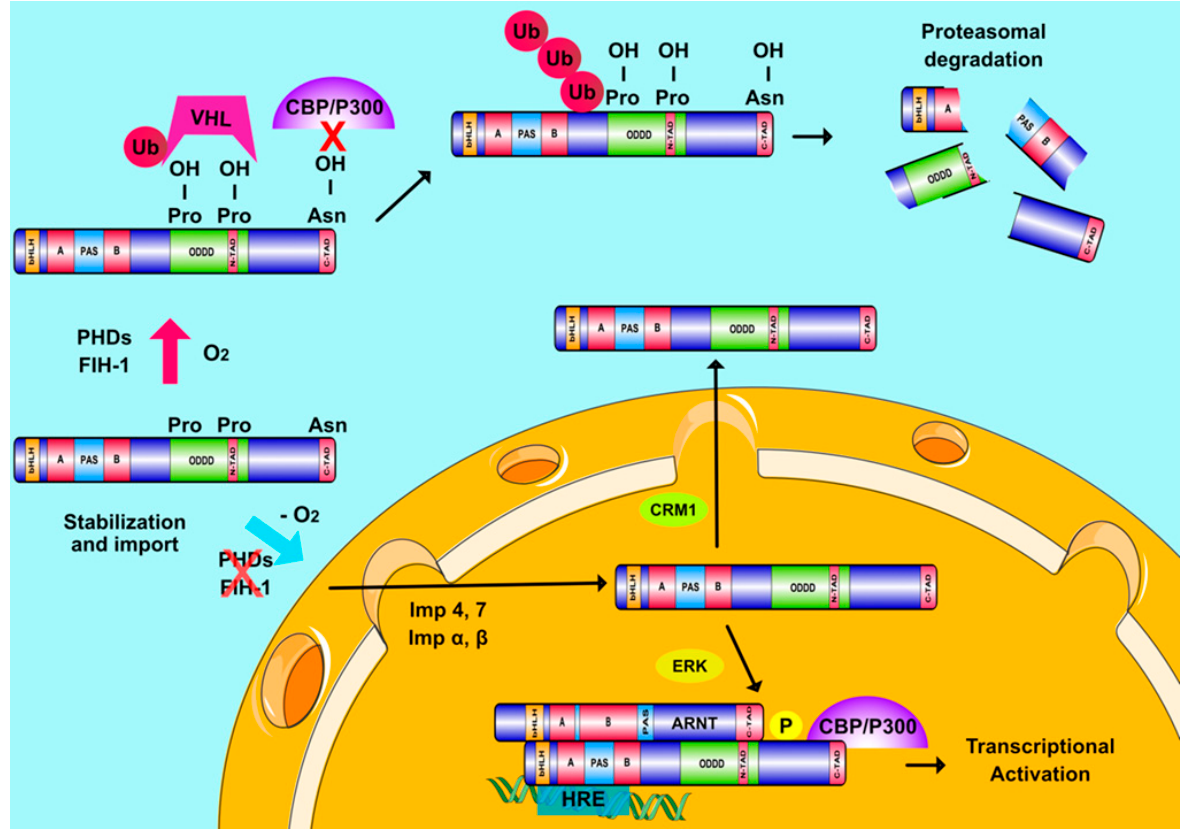
Figure 1. Regulation of HIF α subunits and Hypoxia Inducible Factors (HIF) transcriptional activity. When oxygen is abundant, PHDs and FIH hydroxylate two proline and one asparagine residue inside the ODDD and C-TAD regions of HIF α , respectively. Prolyl-hydroxylation leads to pVHL-mediated ubiquitination of HIF α subunits and their destruction in the proteasome while asparaginyl hydroxylation also inhibits HIF α interaction with CBP/P300. When oxygen levels drop, hydroxylases become inactive and HIF α subunits are stabilized and transported into the nucleus with the help of multiple importins (Imp α , β , 4, and 7). ERK-mediated phosphorylation of HIF α subunits ensures their nuclear accumulation by abrogating the association of HIF α with exportin CRM1. Nuclear HIF α subunits form a functional complex with ARNT, which binds to HREs on DNA and coactivators, such as CBP/p300 to induce transcription of hypoxia-regulated